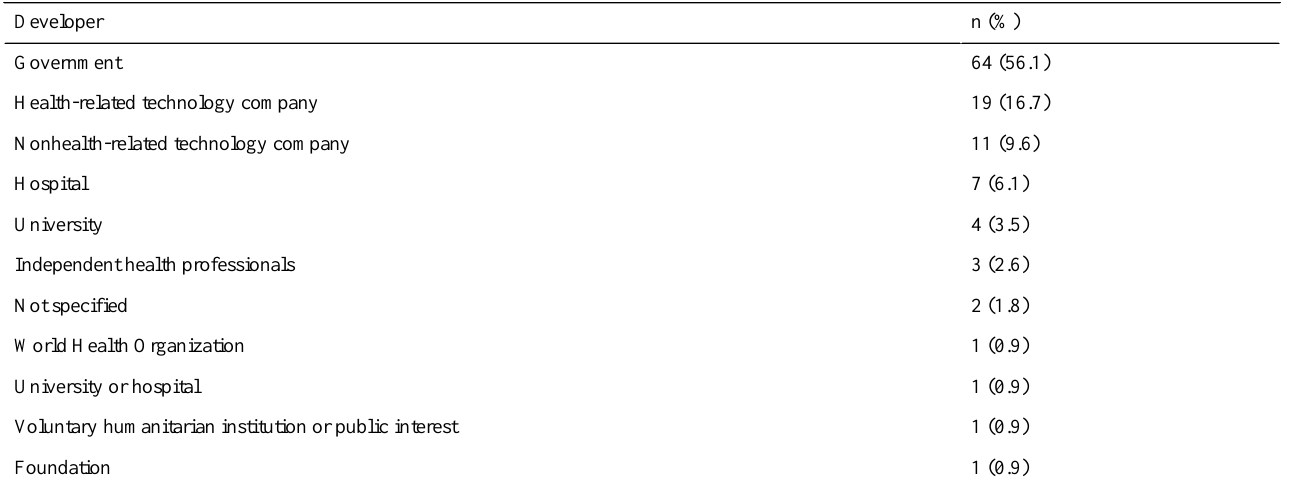
Table 2. Developers of the apps